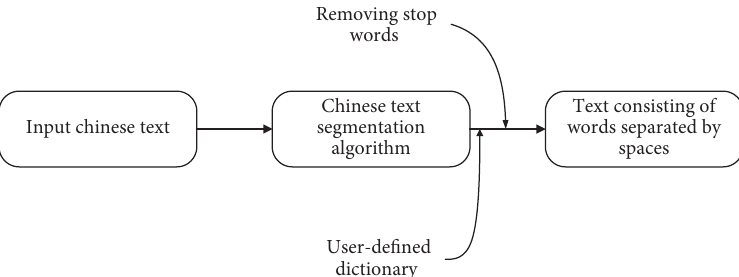
Figure 5: Chinese word segmentation algorithm flow.